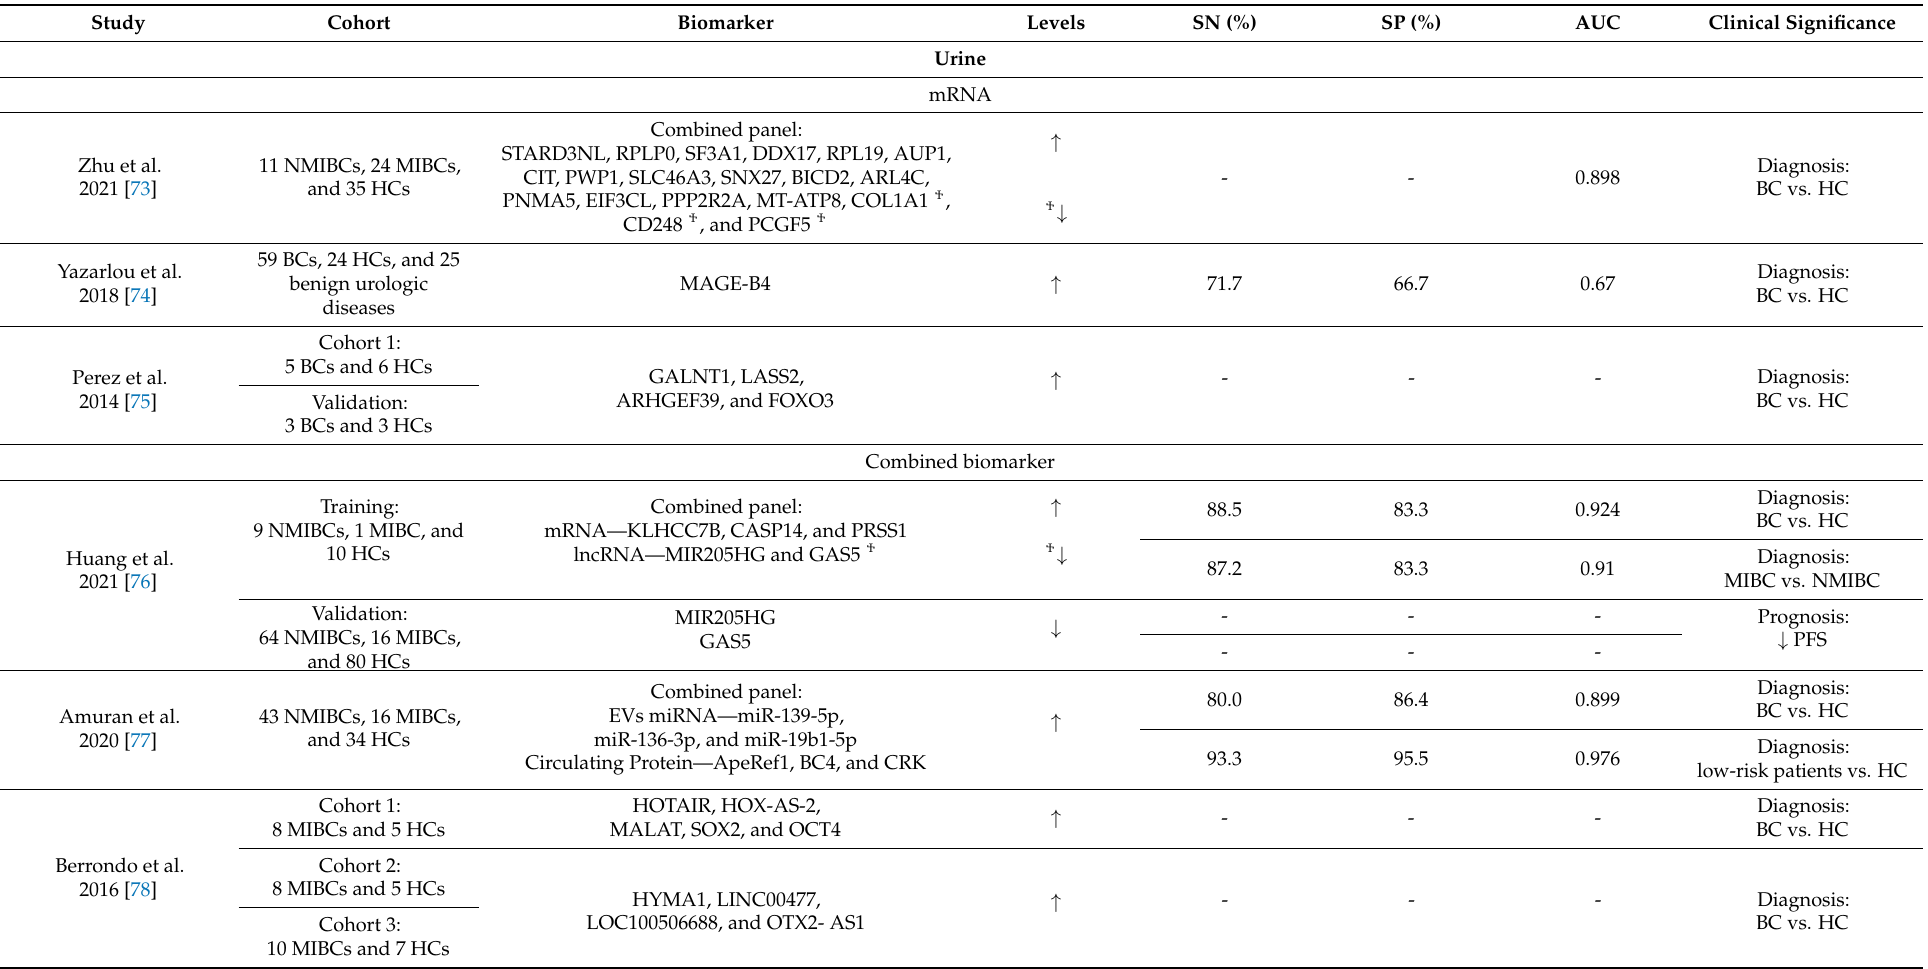
Table 4. Other and/or combined biomarker studies with potential in the management of bladder cancer patients.